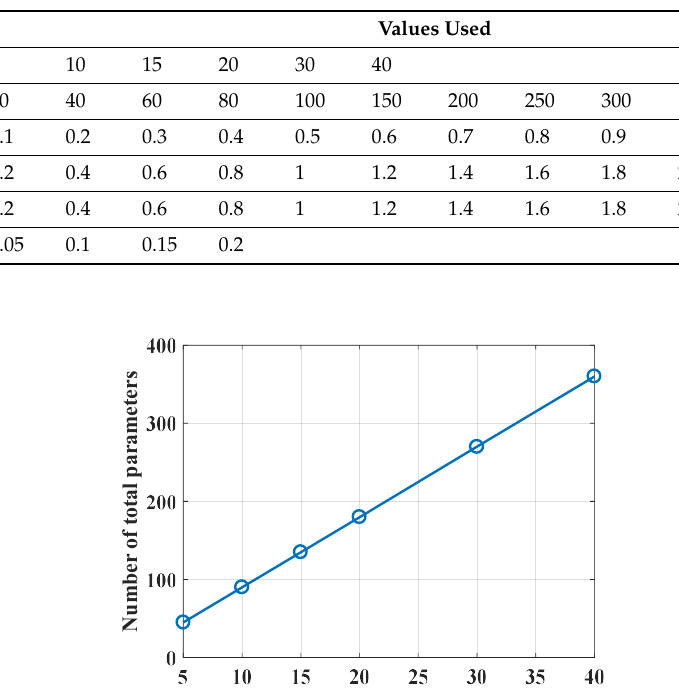
Table 2. Values used for parameters in parametric studies.